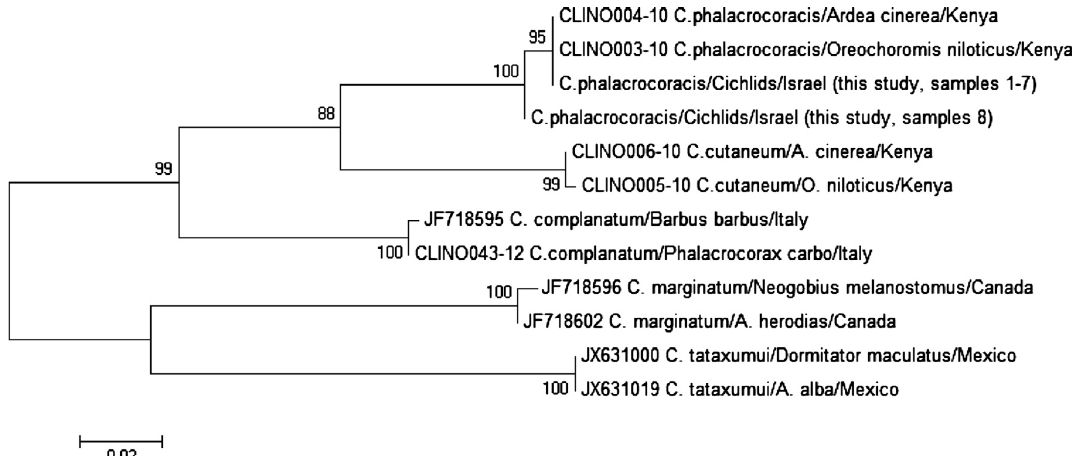
Figure 4. Phylogeny based on the Maximum Likelihood method using COI mtDNA sequences. The numbers correspond to the percentage of bootstrap support values derived from 1000 replicates. Samples 1–7 GB accession numbers KJ786967-KJ786969, KJ786971-KJ786974. Sample 8 GB accession number